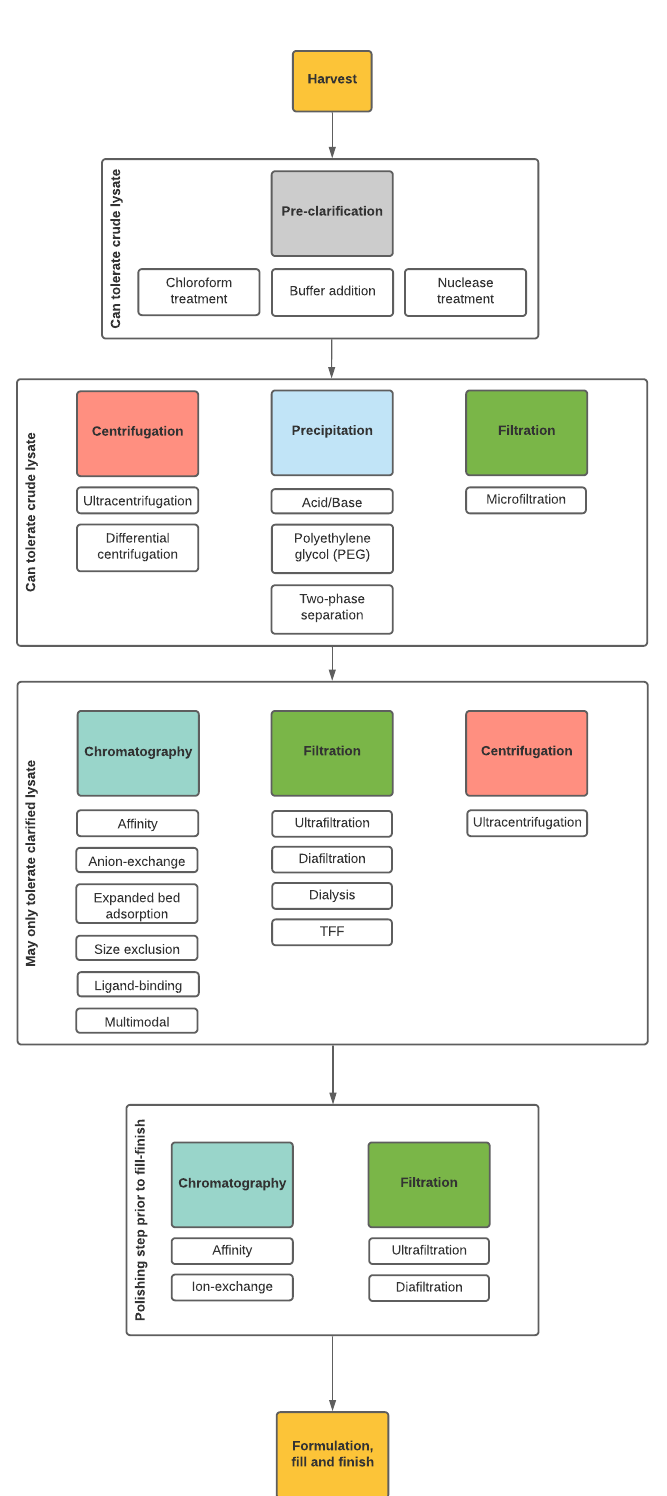
Figure 5. Generalized process flow for phage purification. From harvest, pretreatment is required to collect the phages from the lysate. Crude lysate can be processed using a combination of centrifugation, microfiltration, and precipitation. Once the lysate has been concentrated and the host cell debris reduced, more sensitive procedures may be implemented, such as chromatography and specific types of filtrations. Polishing procedures may be required to further isolate and purify the phage before moving on to fill-finish.